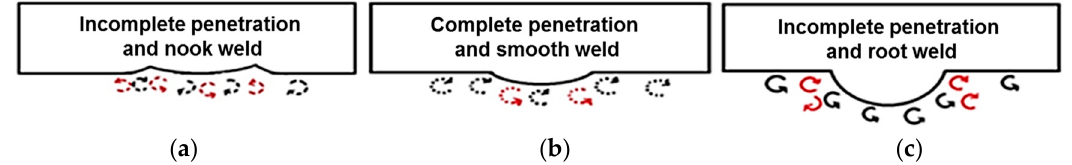
Figure 11. The simulated corrosion with a flow rate of 15 L/min of welded specimens at various welding currents: ( a ) 60, ( b ) 70, and ( c ) 80 A